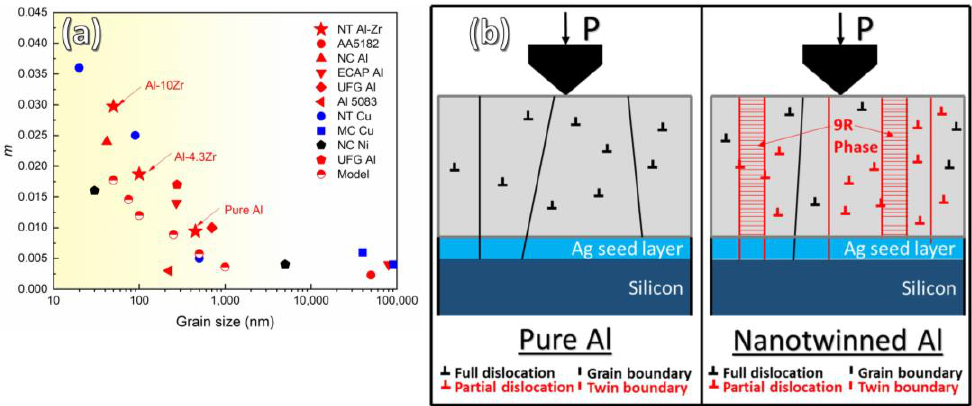
Figure 5. ( a ) Comparison of known values of m for various FCC metals (Al, Ni, and Cu) plotted as a function of grain size as tested using various techniques. The results from the nanoindentation technique are consistent with previous findings and highlight the bolstered strain rate sensitivity in NT Al – Zr alloys [22,24,58,66 – 71]. ( b ) Schematic comparing the UFG Al film with full dislocations and conventional grain boundaries (GBs) with the NT Al – Zr alloys composed of a mixture of GBs and ITBs as well as an abundance of partial dislocations (9R phase).